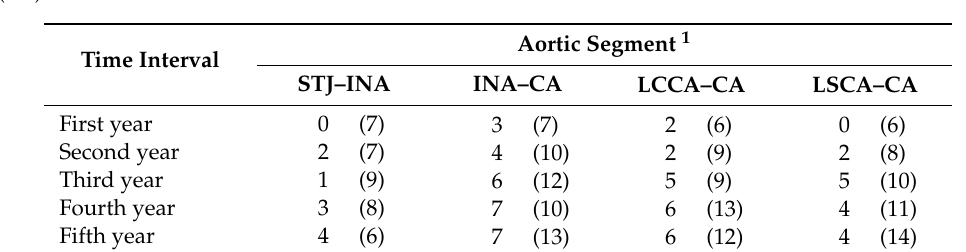
Table 3. Length di ff erence of the aorta as compared with immediate post-TEVAR computed tomography